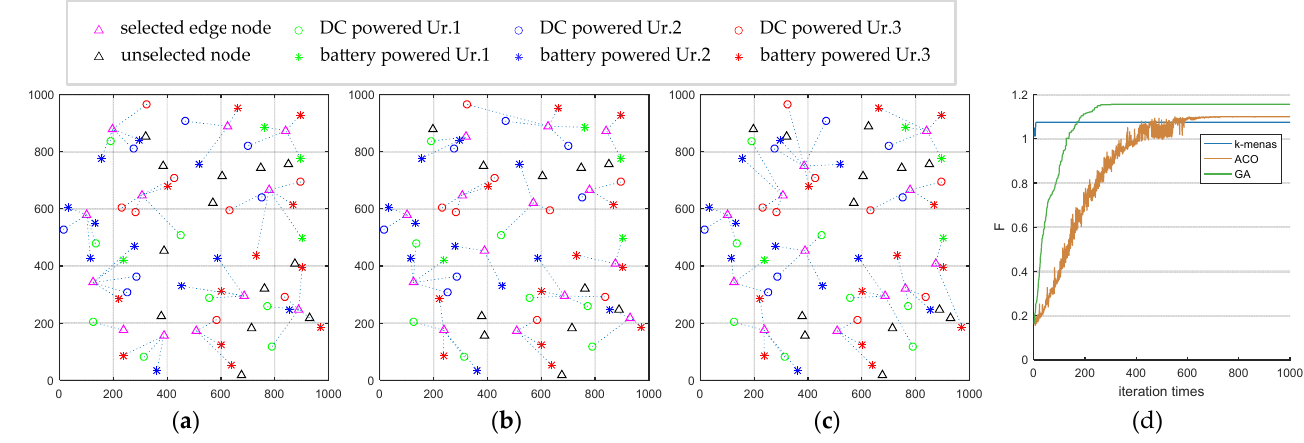
Figure 6. ( a ) K-means distribution; ( b ) ACO distribution; ( c ) GA distribution; ( d ) iteration comparison.